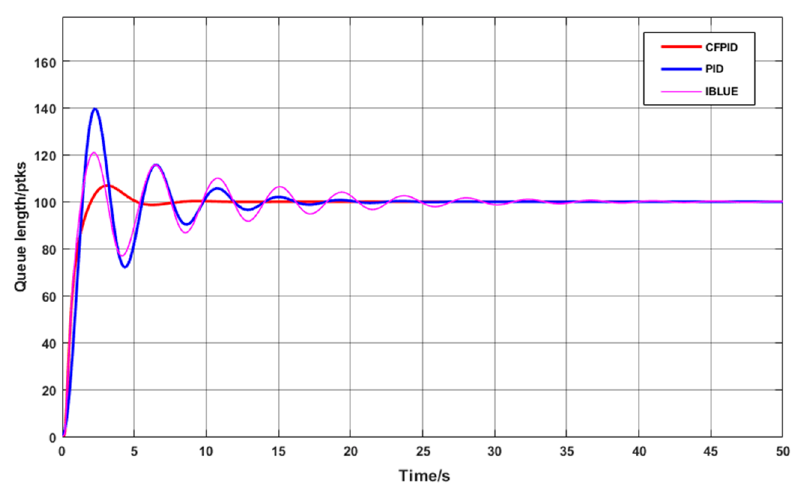
Figure 6. One-hundred instantaneous queue length curves for nodes.